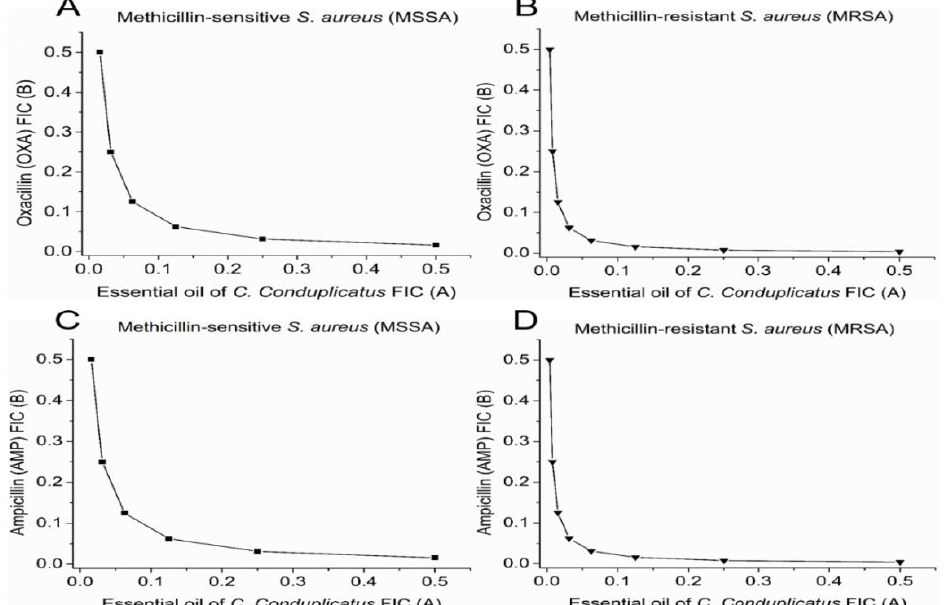
Figure 5. Isobole curves showing the synergistic effect of essential oil from C. conduplicatus leaves with ( A , B ) oxacillin and ( C , D ) ampicillin against methicillin-sensitive Staphylococcus aureus (MSSA) ATCC 25923 and methicillin-resistant Staphylococcus aureus (MRSA) ATCC 33591, respectively.